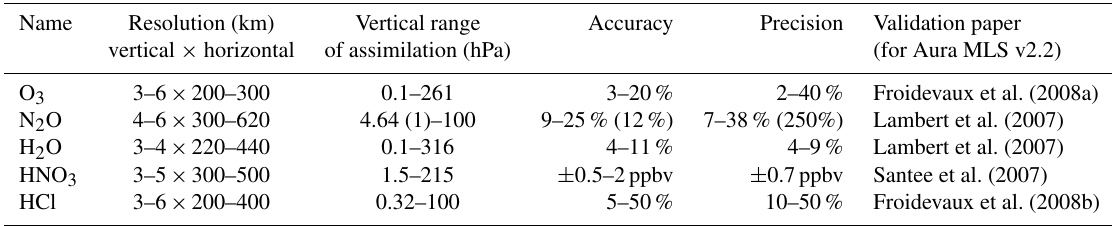
Table 1. List of species retrieved in Aura MLS v4.2 and assimilated for this